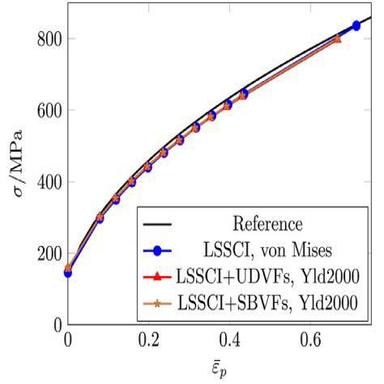
Comparison of identified flow stress curves at 0∘ orientation.